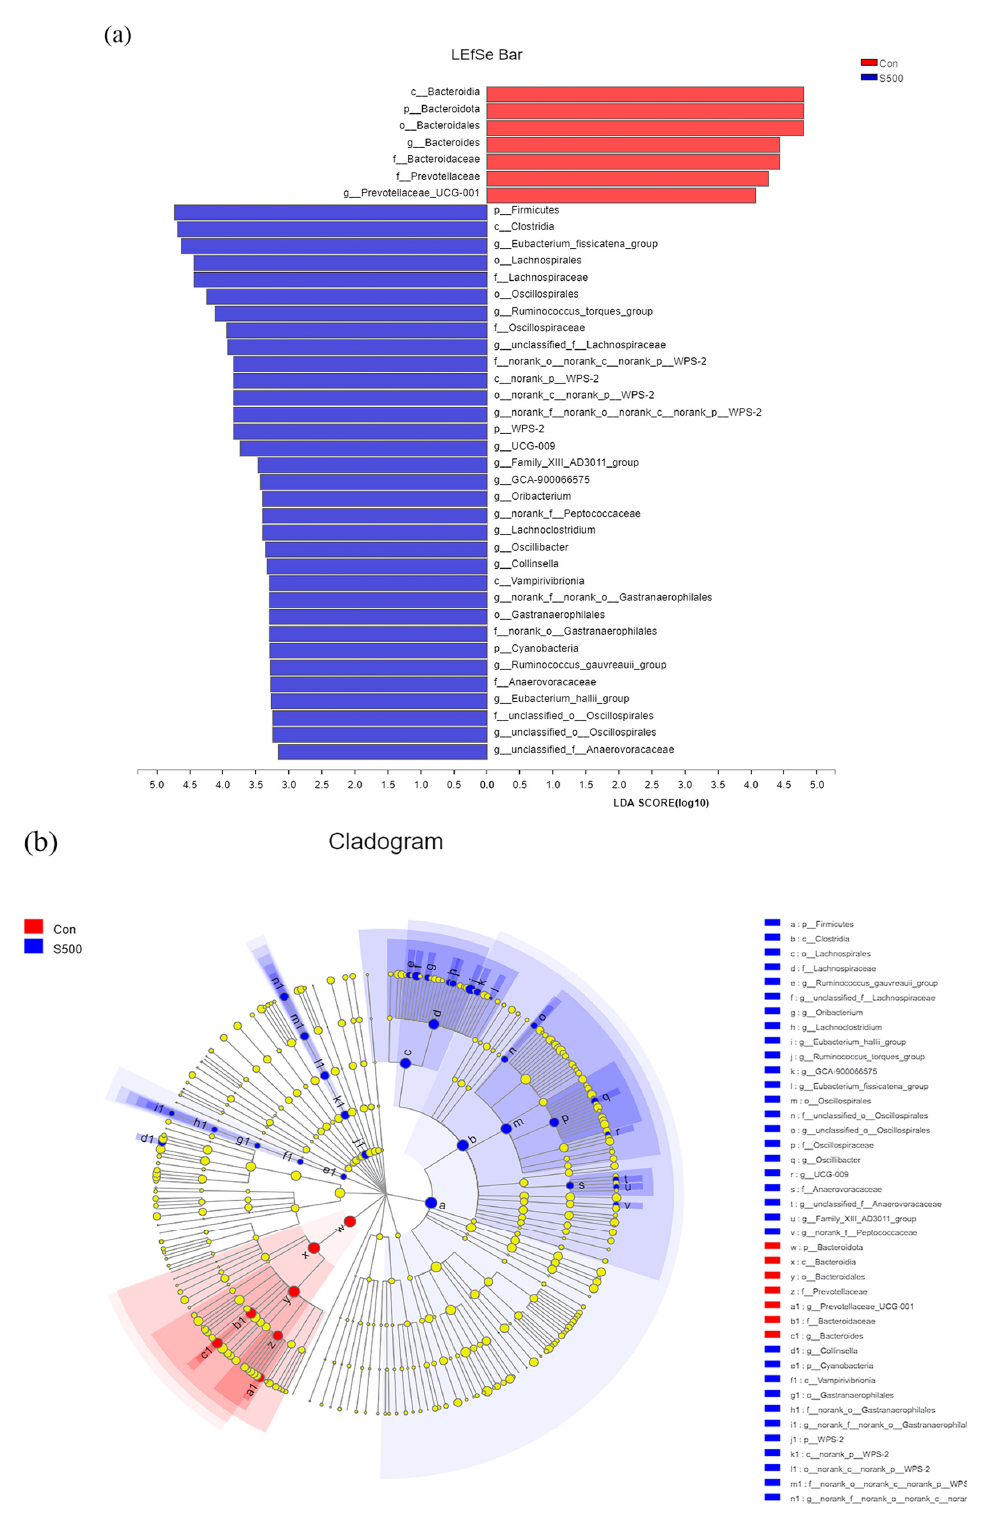
Figure 8. LEfSe ( a ) and LDA ( b ) analyses based on OTUs characterized the microbiomes of the control and S500 groups.